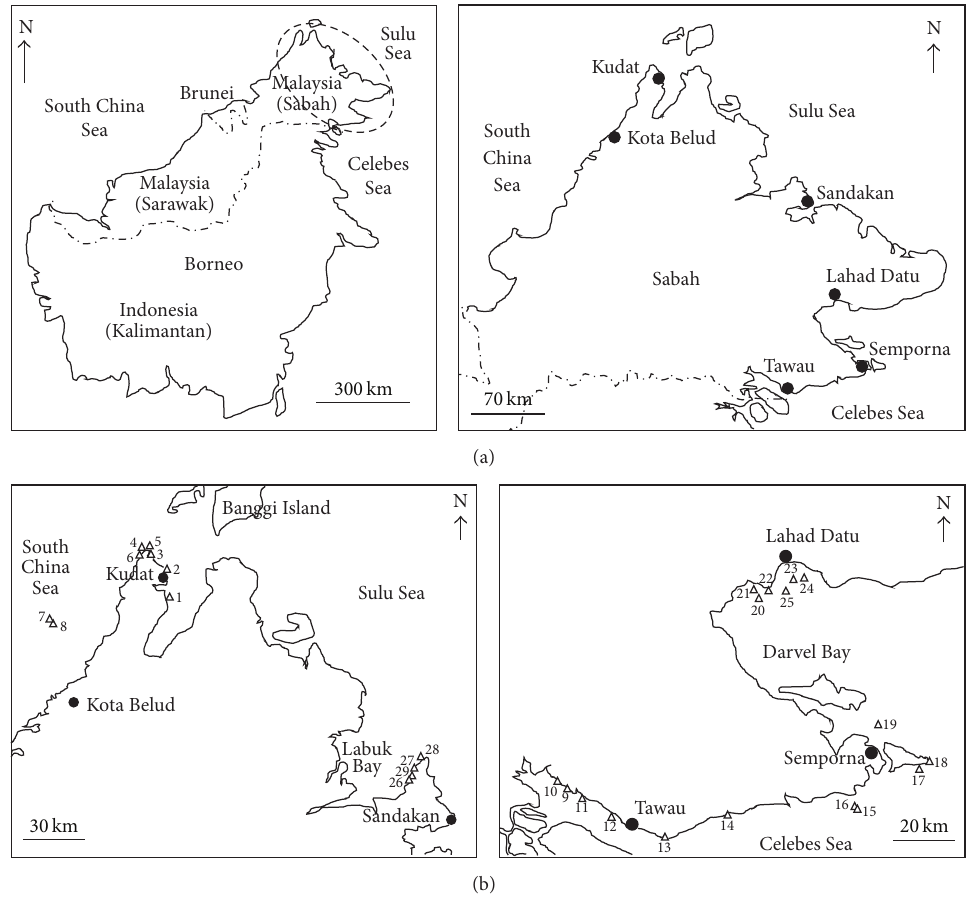
Figure1:(a)EastcoastofBorneoIsland.(b)ThestudysiteswithinsixdistrictsinSabah,Malaysia,asfollows:1-Limau-LimauanBeach,2-Bak- Bak Beach, 3-Suangpai Village Beach, 4-West Simpang Mengayau, 5-East Simpang Mengayau, 6-Kelambu Beach, 7-West Mantanani Island,